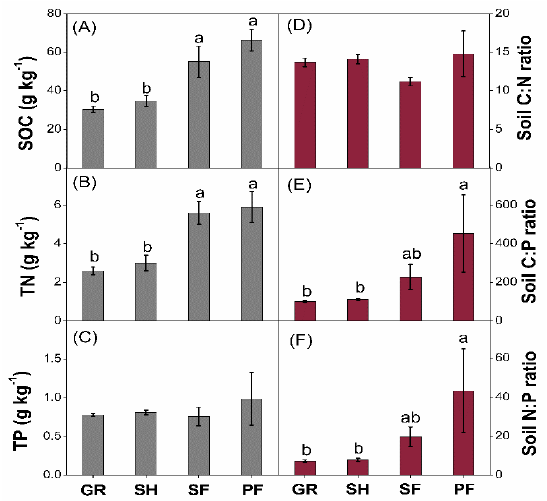
Figure 2. Changes in SOC ( A ), TN ( B ), TP ( C ), and stoichiometric ratios of soil C:N ( D ), C:P ( E ) and N:P ( F ). along vegetation succession in a karst region of southwest China. GR = grassland, SH = shrubland, SF = secondary forest, and PF = primary forest. Values are the means ± SE ( n = 6). Different lowercases on the column denote significant difference between successional stages at p < 0.05.